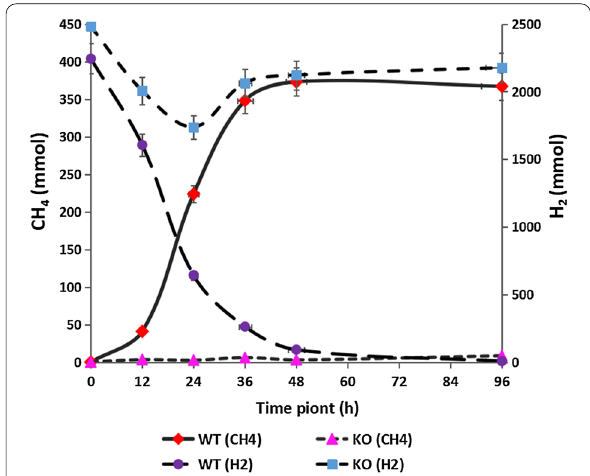
Fig. 5 The concentration changes of methane production and hydrogen consumption in WT and KO cofD type M. ruminantium at